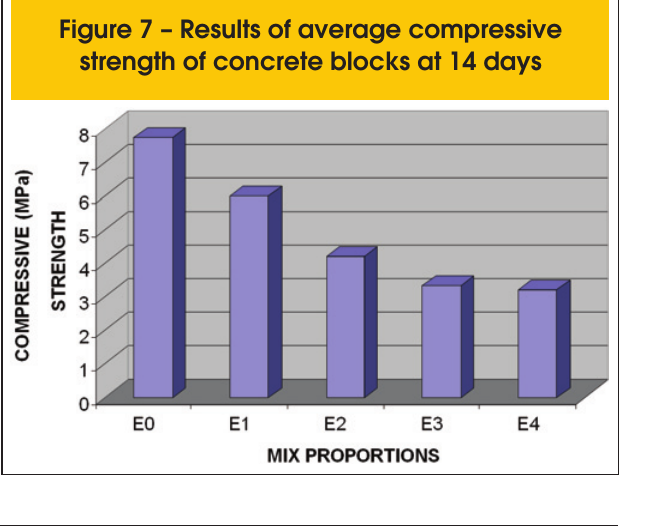
Figure 8 – Results of average compressive strength of concrete blocks at 28 days